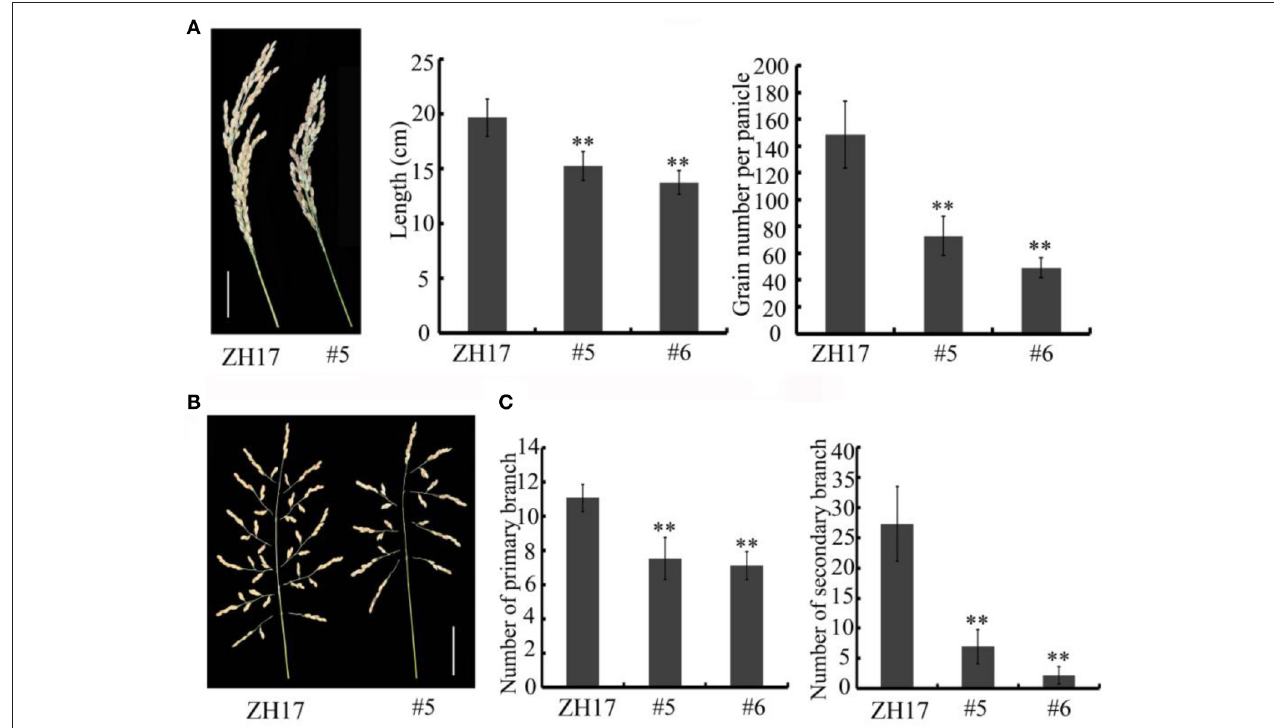
FIGURE 5 | Overexpression of OsCEP6.1 modulates panicle architecture in rice. (A) OsCEP6.1 overexpression lines exhibited shorter panicles and fewer grains per panicle compared with the control (ZH17). Bar = 5cm. The values are means ± SD ( n ≥ 12 ), ** P < 0.01 . (B) Panicle branching. Bar = 5cm. (C) The